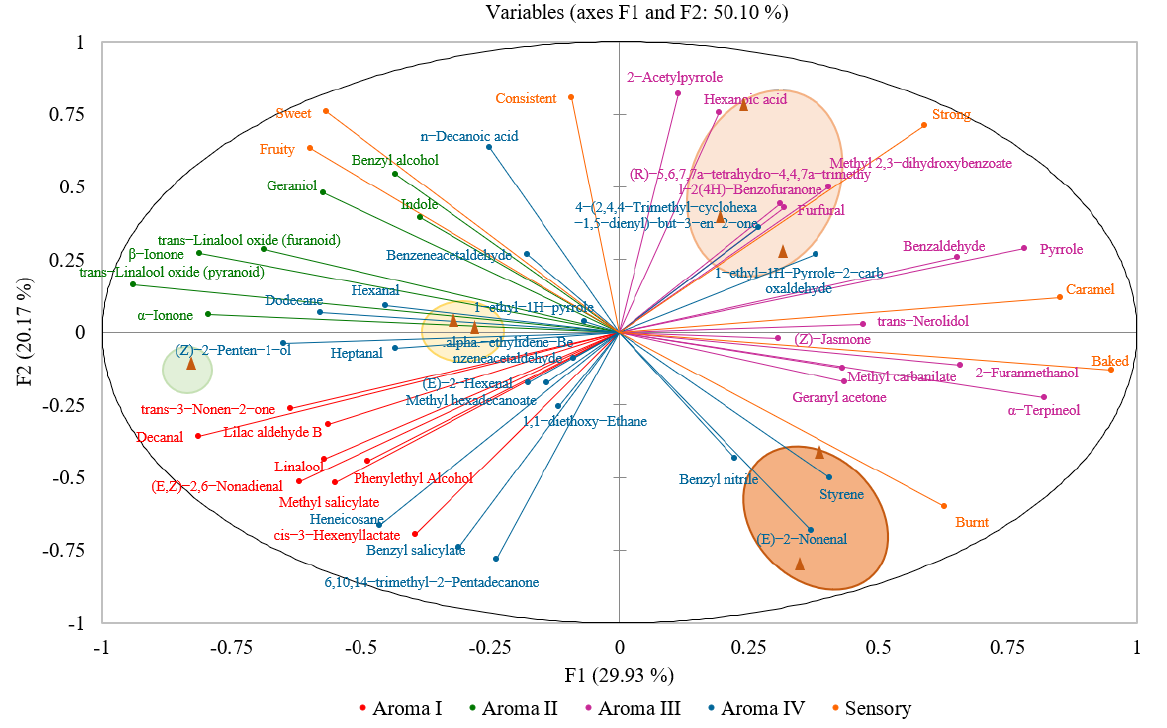
Figure 5. The combination of aroma attributes and aroma compounds correlation diagram and samples distribution diagram in aroma-enhanced Yunnan congou black teas baked at 90 ◦ C (0–7 h). The green circle represents DH-CK; the yellow circle represents DH-1 and DH-2; the light-orange circle represents DH-3, DH-4, and DH-5; the orange circle represents DH-6 and DH-7. The exact location of the tea samples can be seen in Figure S3.